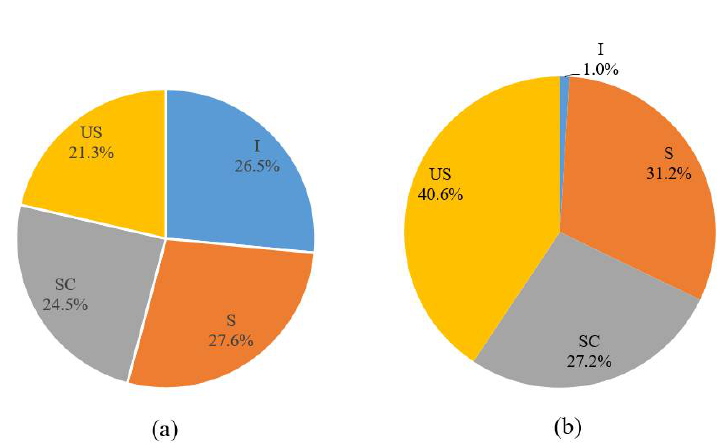
Figure 5. Route type distribution for: ( a ) RCP culverts and ( b ) CMP culverts measured by length.